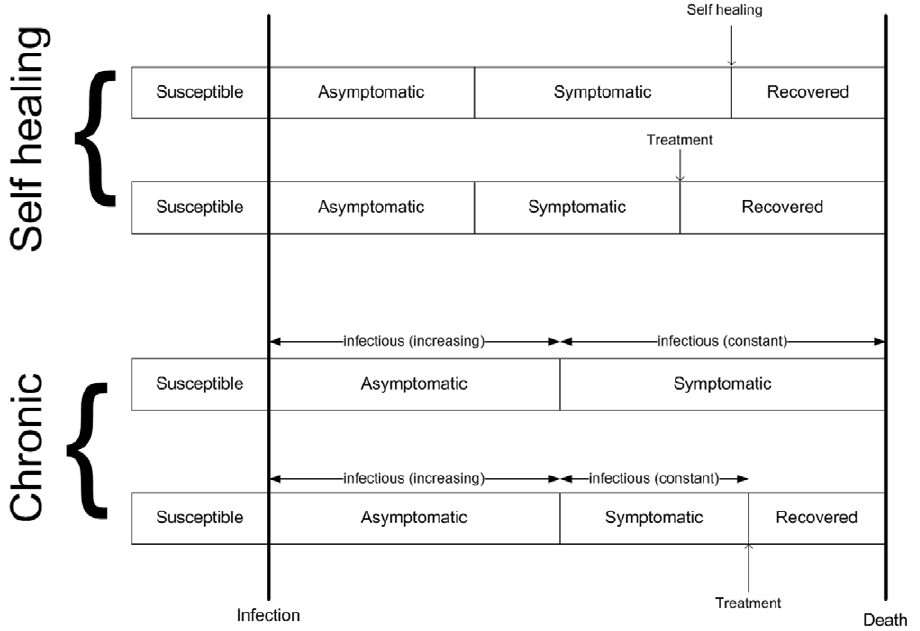
Figure 1. Natural history of infection from birth until death, for self-healing and chronic leprosy in the model. Both types of leprosy, self-healing and chronic, start in a susceptible state. Self-healing enters an asymptomatic state, progresses to the symptomatic or clinical state, is followed by self-healing or treatment, and finally transitions to the recovered state. The chronic form enters a different asymptomatic state after infection. Here, the infectivity, i.e. the probability of transmission during an adequate contact, increases with the duration in this state. When progressing to the symptomatic state, the infectivity reaches the maximum and remains constant. The individual will stay in this symptomatic state until death unless treatment is provided. Treatment results in a transition to the recovered state, in which the individual is no longer infectious.